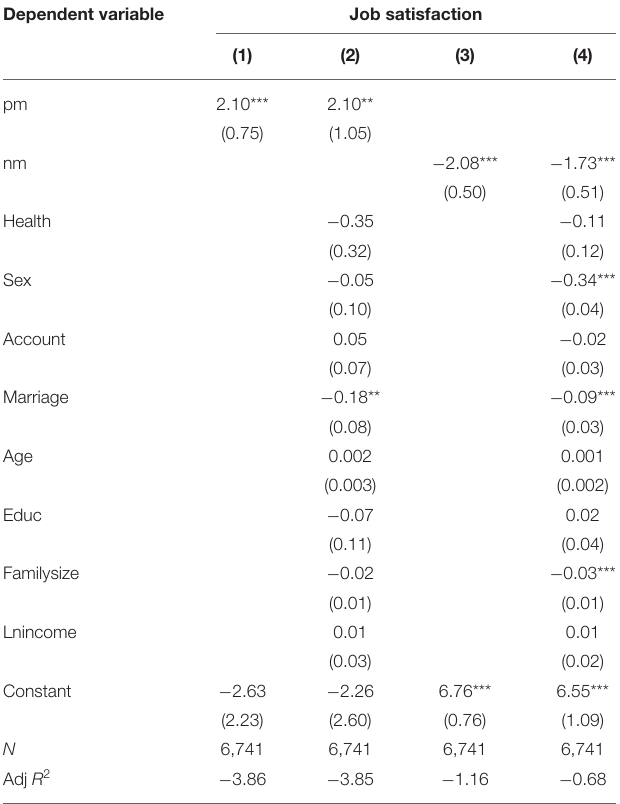
TABLE 4 | The results of instrumental regression. Dependent variable